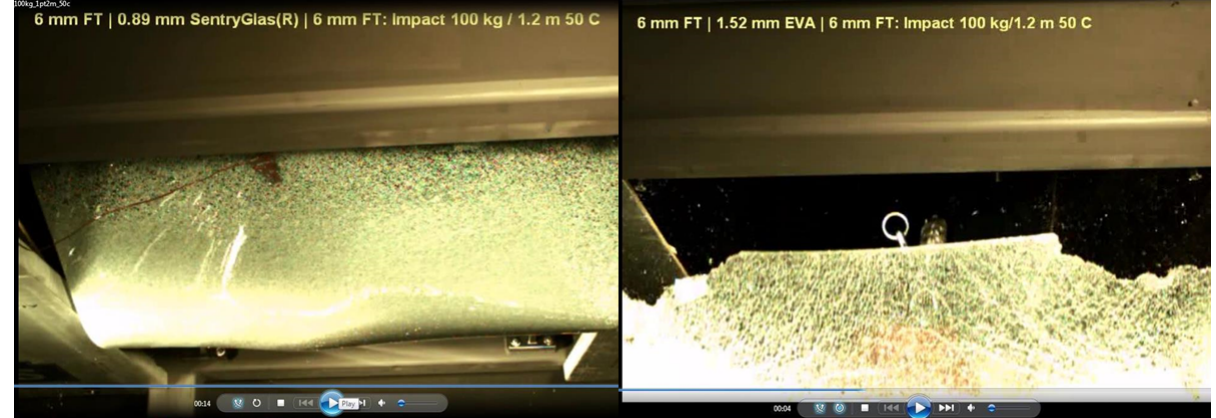
Fig. 3 Ionomer laminate provided “Fall Through” resistance, view from below during the impact